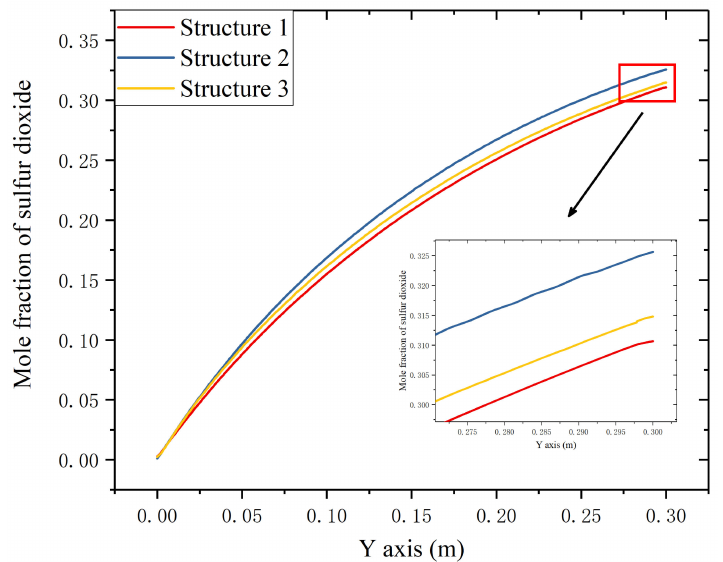
Figure 10. Comparison of the predicted sulfur dioxide molar fraction distribution in the annulus.